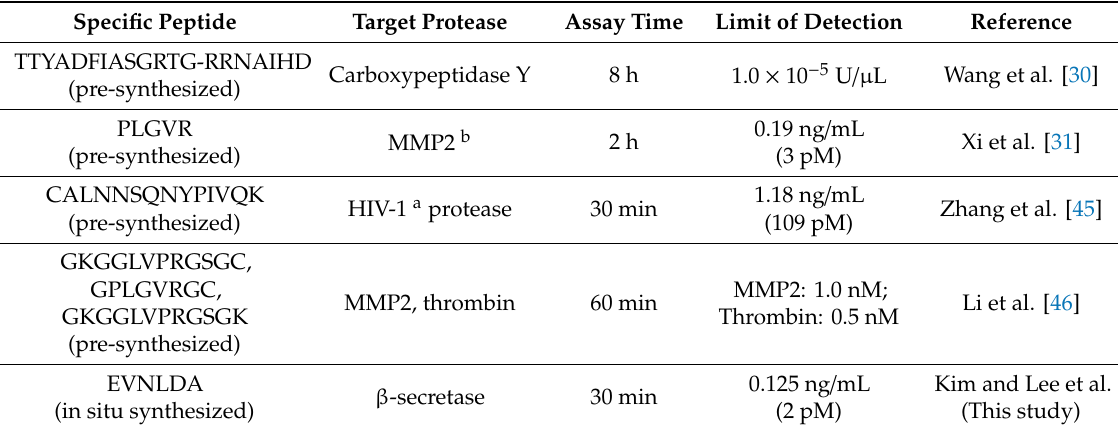
Figure 7. Fluorescence signals from FITC-EVNLDA-PEG 800 -MGO biosensors upon peptide cleavage by β -secretase. ( A ) Fluorescence emission spectra of FITC-EVNLDA-PEG 800 -MGO FRET biosensors in the presence of β -secretase at concentrations of 0 to 8 µ g / mL for 30 min. ( B ) Fluorescence intensity recovery (F / F 0 ) at 514.5 nm from FITC-EVNLDA-PEG 800 -MGO in response to di ff erent concentrations of β -secretase when compared to BSA. ( C ) Temporal fluorescence emission spectra of FITC-EVNLDA-PEG 800 -MGO FRET biosensors from 0 to 60 min at 2 µ g / mL of β -secretase. ( D ) FRET activities of FITC-EVNLDA-PEG 800 -MGO for various proteins at a protein concentration of 0.1 µ g / mL. Table 1. Comparison of protease assay performance on FRET-based graphene–peptide complexed